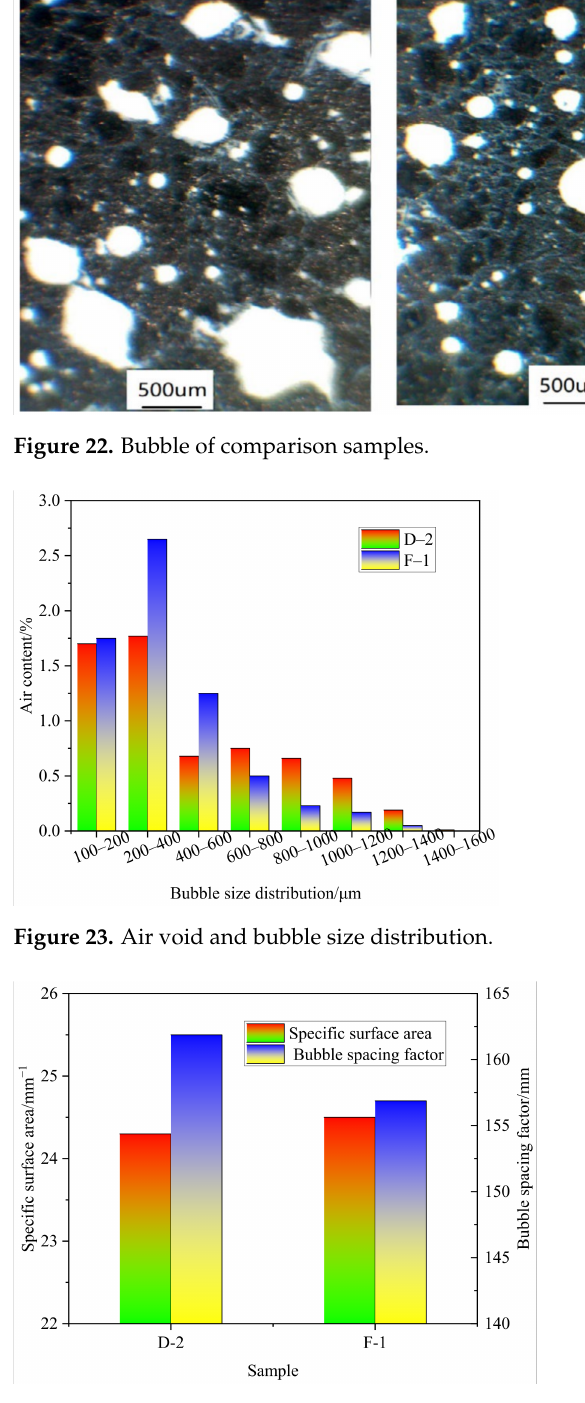
Figure 24. Comparison of the specific surface area and spacing